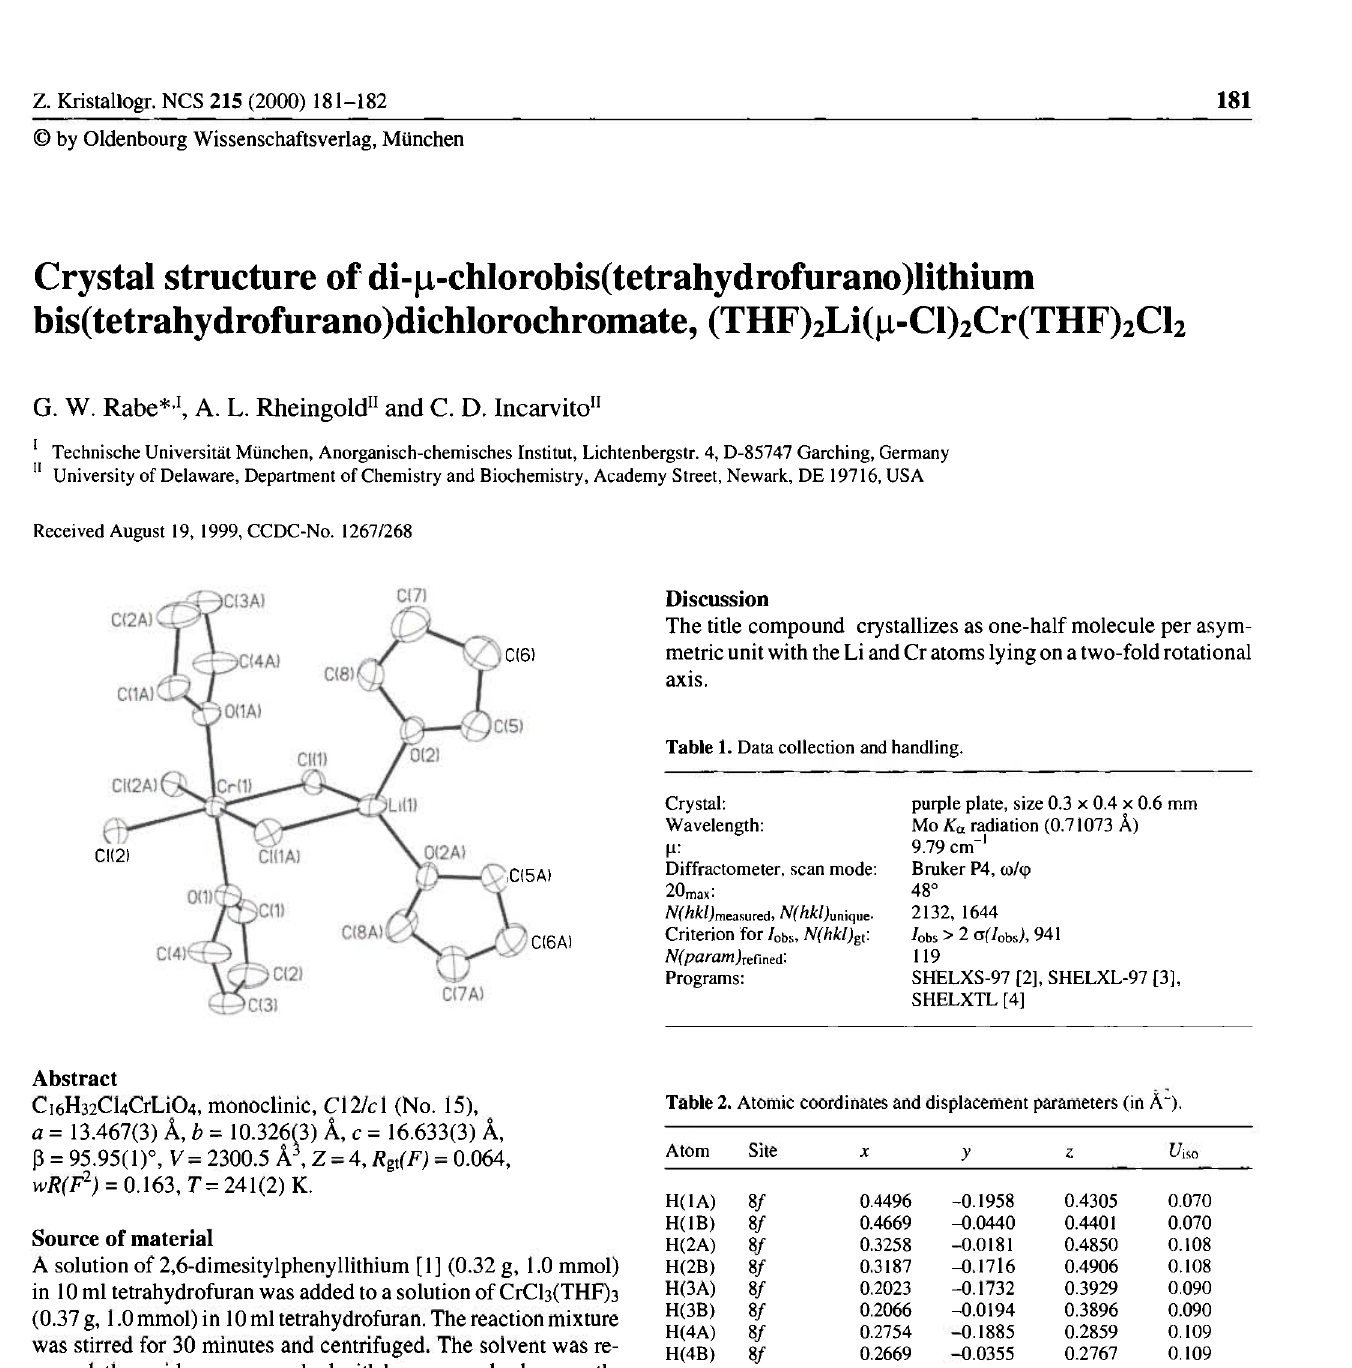
Table 3. Atomic coordinates and displacement parameters (in Ä 2